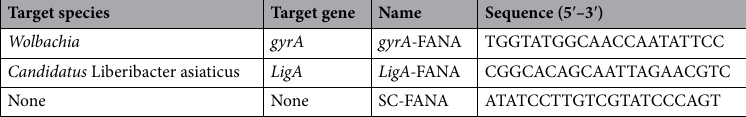
Table 1. Sequences of FANA ASO used in this